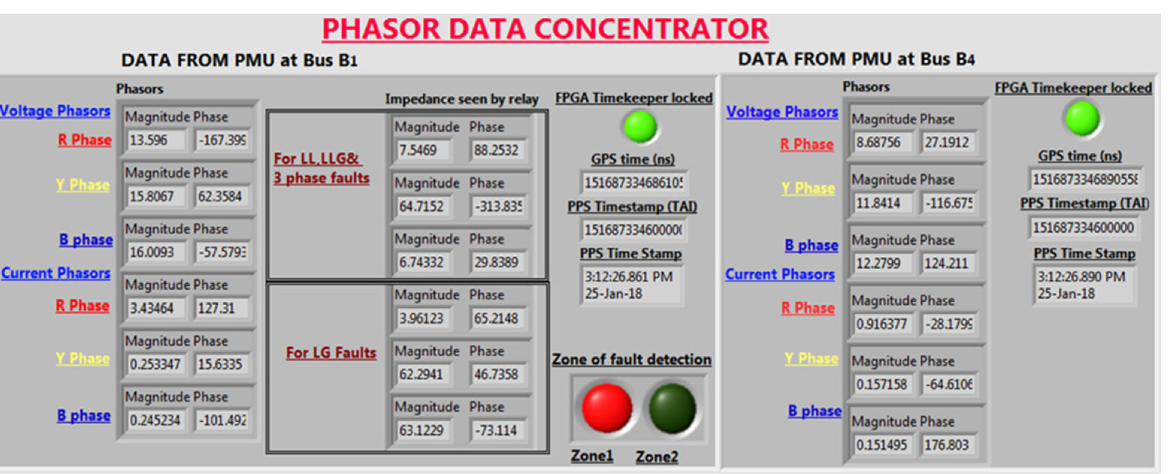
Fig. 10 LabVIEW front panel display of PDC at SPC showing the performance of distance relay R A without the proposed PAZSD methodology for LG fault (FR = 0.2 Ω ) at 50 km from B